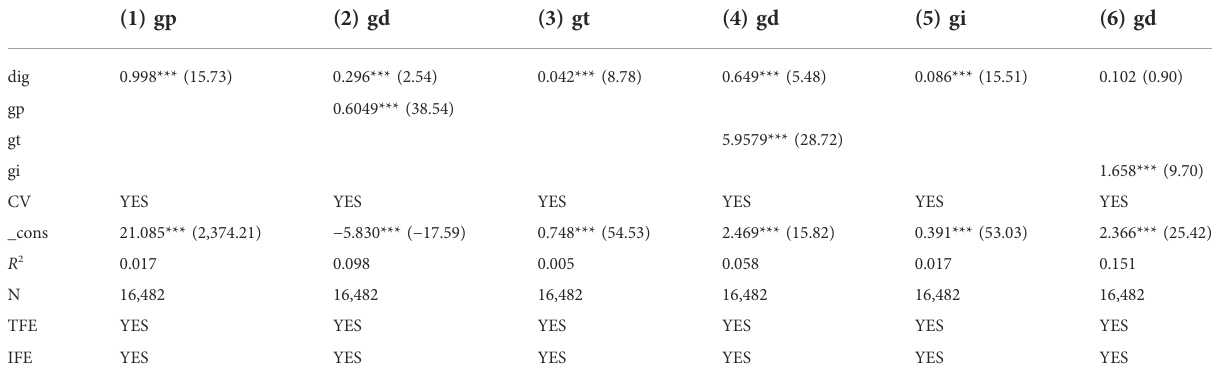
TABLE 4 Results of the mediation effect